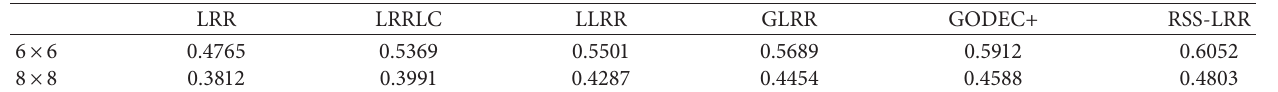
Table 8: Classification accuracies on COIL100 under 6 × 6 and 8 × 8 occlusions.